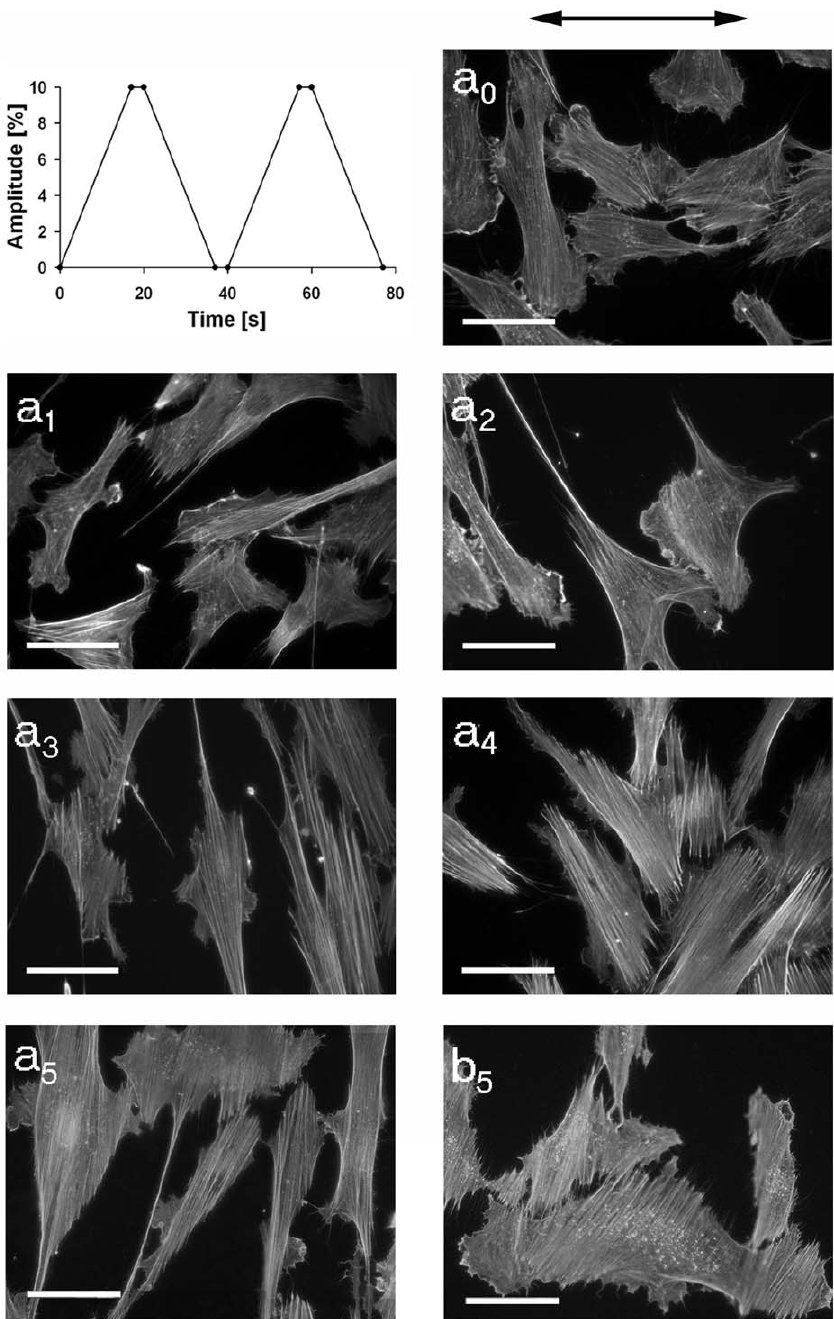
Figure 2. Cell reorientation upon cyclic stretch. Stretch cycles as indicated (top left) of various amplitudes (a 0 (0%), a 1 (4.9%), a 2 (8.4%), a 3 (11.8%), a table 1. Scale bars, 50 m m. doi:10.1371/journal.pone.0028963.g002 to the intrinsically ‘‘preferred’’ value of stress or strain. Reactions of cells are derived from this effective free energy by standard methods of statistical physics. As can be clearly seen at high strains (Fig. 4), the cells studied here do not orient towards minimum stress direction (90 u ), instead they preferred directions closer to the minimum strain direction (69 u in box-shaped chambers and 62 u on ribbons). Because of this observation, for the given stretch PLoS ONE |